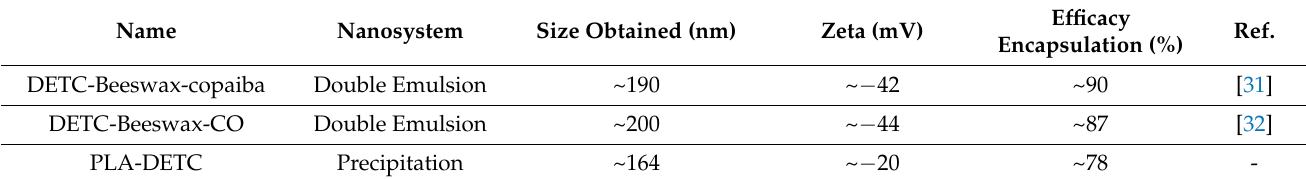
Table 3. Comparative table of findings in the literature on the use of nanoparticles with DETC against the Trypanosomatidae